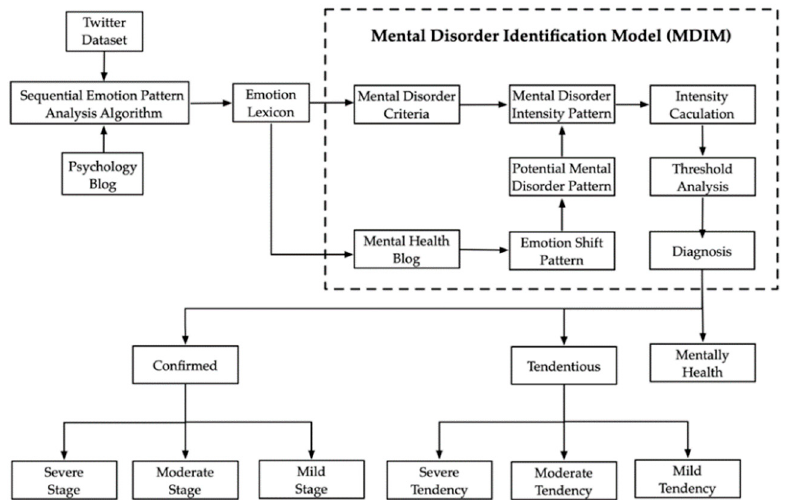
Figure 3. Flowchart of the Mental Disorder Identification Model (MDI-Model) with sequential emotion pattern analysis.